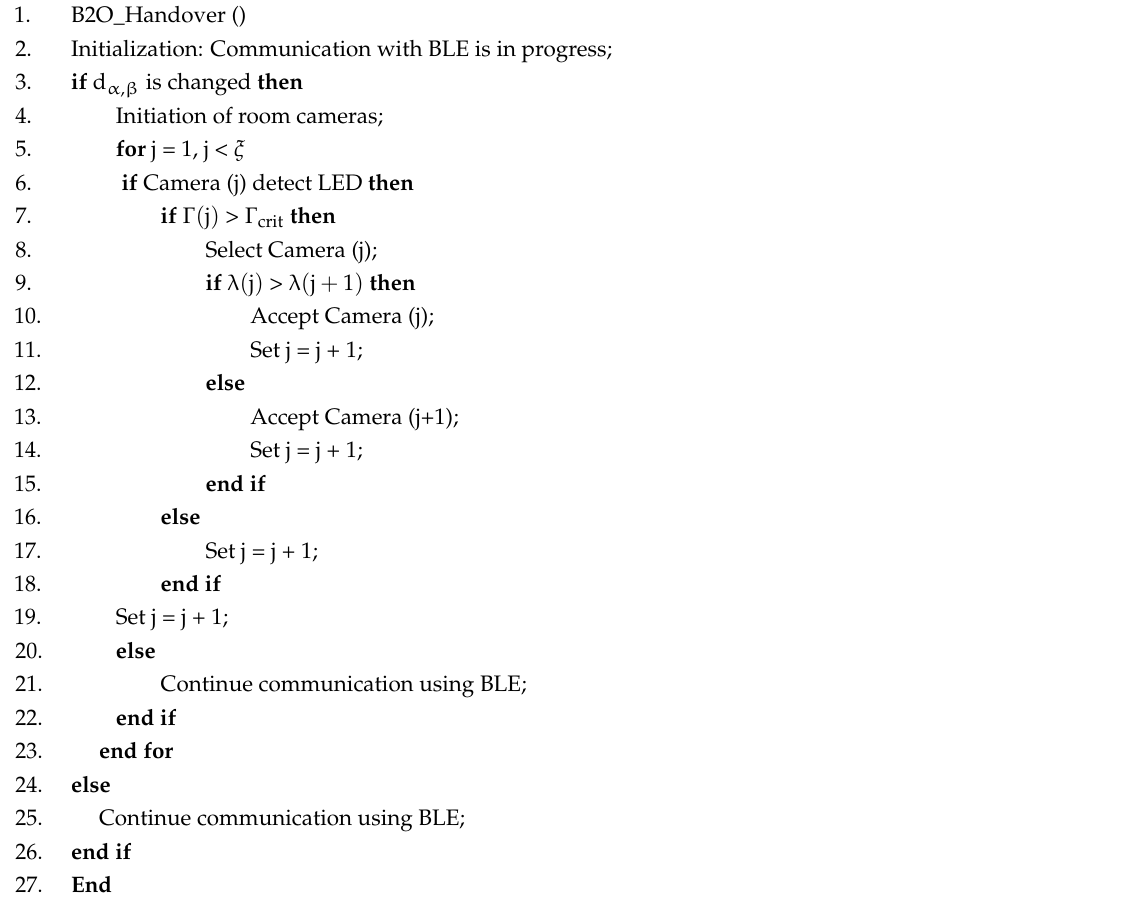
Algorithm 4: Network switching algorithm BLE to